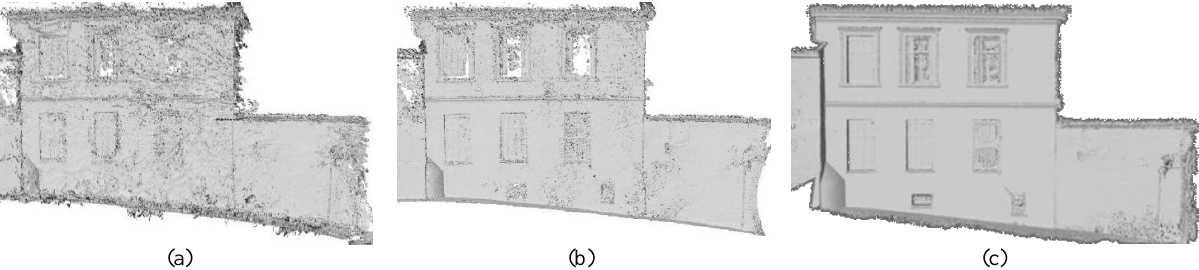
Figure 4: (a) Dense point cloud using the action cameras and 360° cameras (b) Dense point cloud using only the action camera and